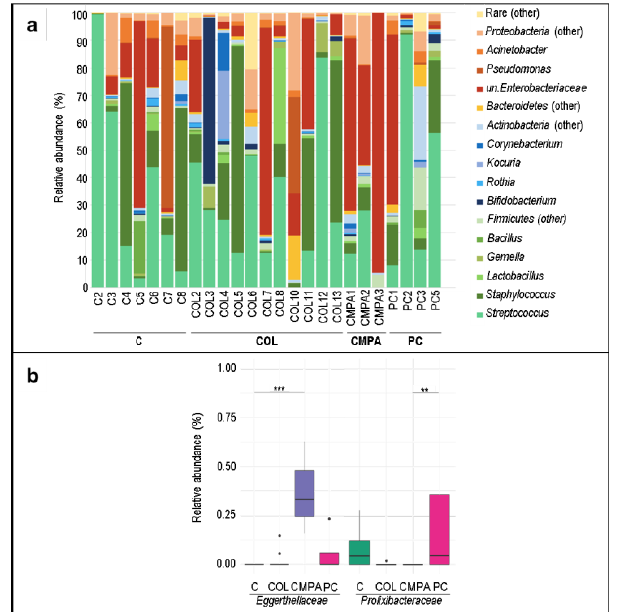
Figure 3. Bacterial composition of milk samples: ( a ) Relative abundance of the major bacterial genera detected in ≥ 15% of the milk samples; ( b ) Relative abundances of the significantly different bacterial families resulting from LEfSe analysis of the milk samples ( N = 25). Statistical differences between the study groups are indicated with an asterisk (**, p < 0.05; ***, p < 0.01; Dunn test). C, Control group ( n = 7); COL, Colic group ( n = 11); CMPA, Cow’s milk protein allergy group ( n = 3); PC, Proctocolitis group ( n = 4). In these boxplots, the central rectangle represents the interquartile range (IQR), the line and the cross inside the rectangle show the median and the mean, respectively; the whiskers indicate the maximum and minimum values, and the black dots outside the rectangles are suspected outliers (>1.5 × IQR). Nutrients 2020 , 12 , x FOR PEER REVIEW